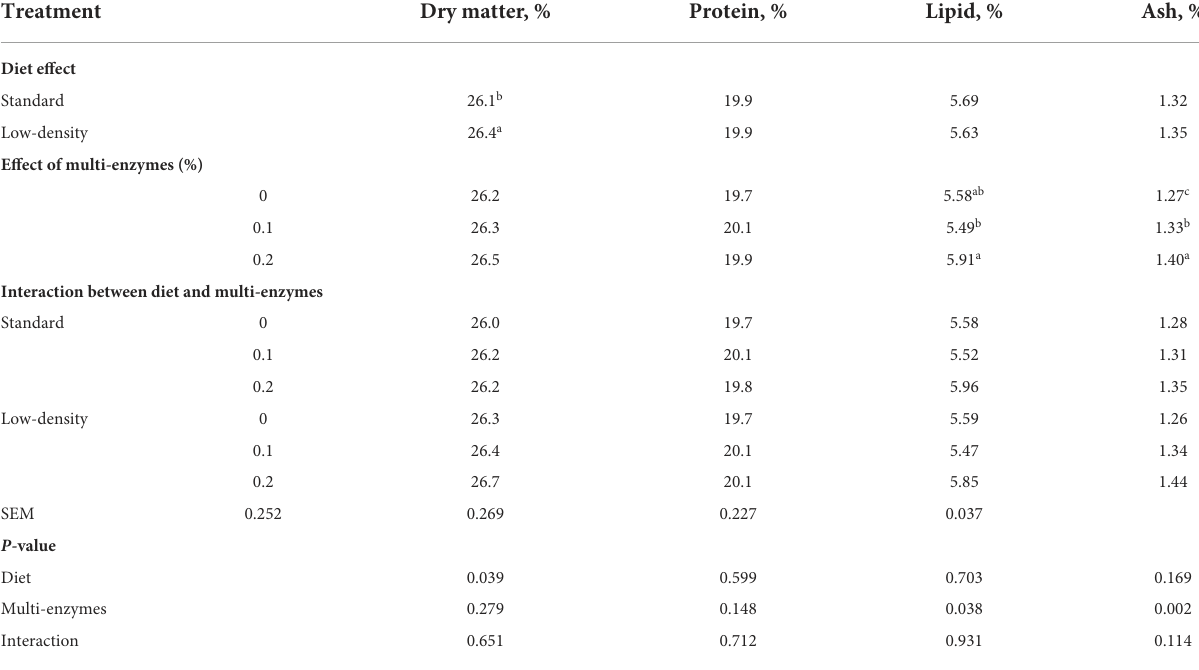
TABLE 7 Chemical composition of broiler meat 1 fed standard and low-density diets supplemented with different concentrations of multi-enzymes from 1 to 38 days of age. Treatment